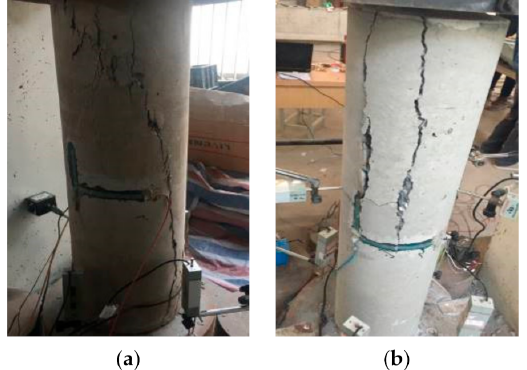
Figure 7. Failure of the unreinforced specimens. ( a ) P1 axial compression failure; ( b ) P2 axial compression failure.